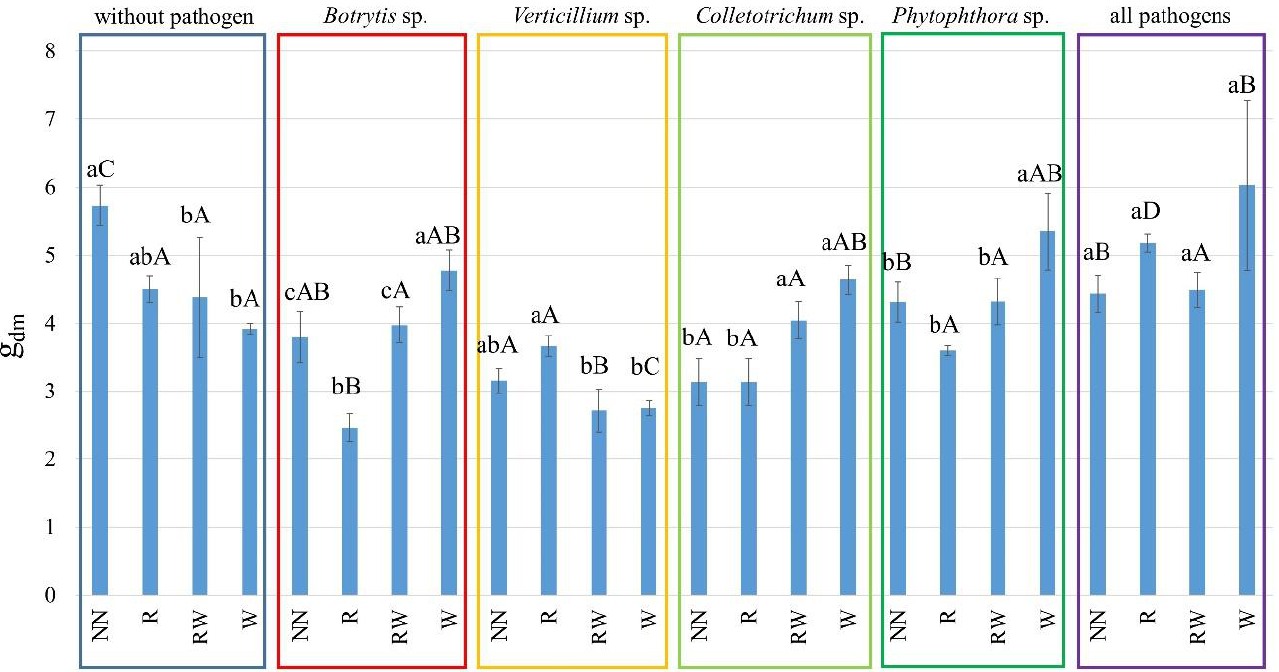
Figure 3. The early effect of the bacterial consortium on Polana raspberry plant growth in the pot experiment depends on the pathosystem and naturalization strategy applied. The dry biomass of shoots varies, according to pathosystems Botrytis cinerea , Verticillium sp., Colletotrichum acutatum , Phytophthora sp., and all pathogens ( Botrytis , Verticillium , Colletotrichum , Phytophthora ) used and also without pathogens, within different biopreparation application strategies: no naturalization (NN), root inoculations (R), root inoculations and watering (RW), and watering (W). The error bars indicate a standard deviation, n = 3, different lowercase letters above the bars indicate differences within the particular pathosystems, and different capital letters above the bars indicate differences within the particular naturalization strategies (according to ANOVA with p < 0.05).